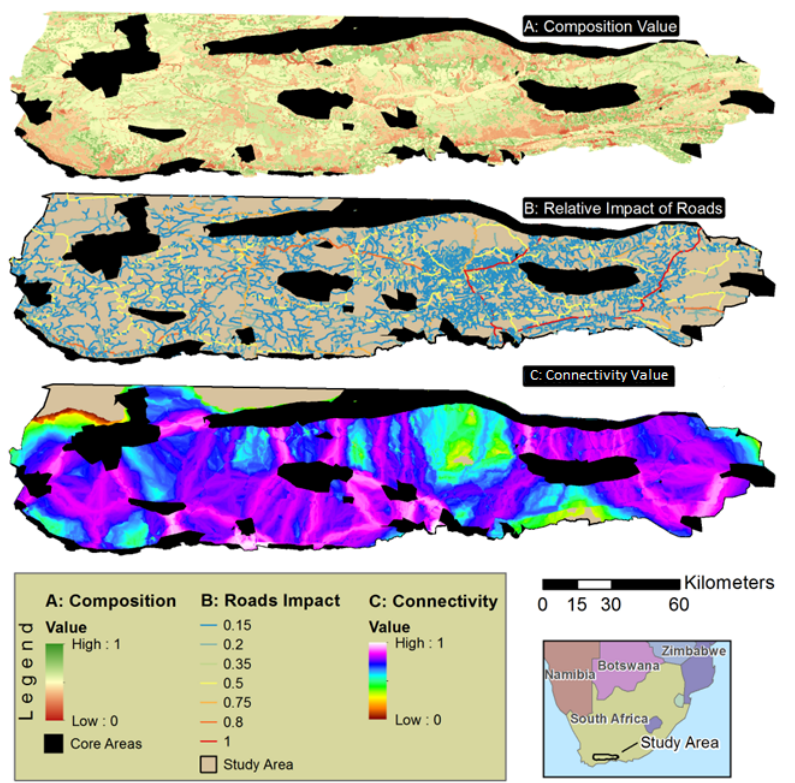
Figure 12. Key input layers and output for the Connectivity Analysis. Note: The connectivity value displayed in the third map down is for the first iteration of the heuristic. It changes as more planning units are added to the solution set. Note also how some linkages mapped as higher priority have broader swaths of